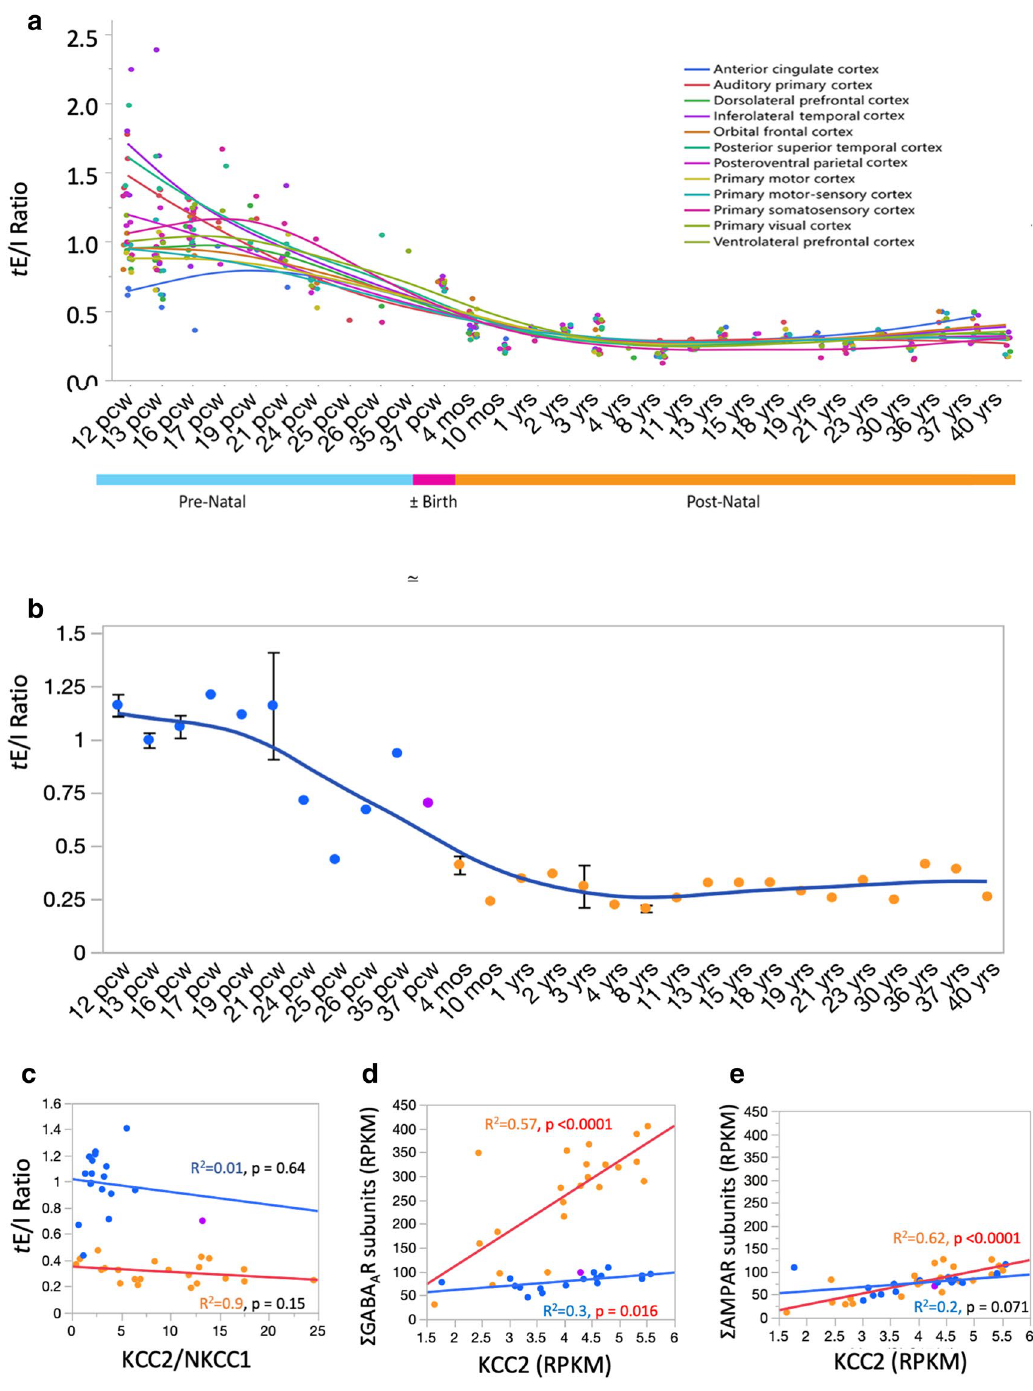
Figure 6. t E/I ratio and KCC2/NKCC1 ratio in the developing human brain. ( a ) t E/I ratios were calculated in different cortical regions against age (from 12 postconceptional weeks to 40 years, shown as categorical values in the plot) using data from the Allen Brainspan project ( n = 40 subjects). Each point represents a single cortical region per subject. Spline smooth curves, here and in ( b ), show the principal trend in values for AMPA and GABA A receptors. Please see Supplementary Data 9 for detailed number of subjects per region. ( b ) The graph shows the mean ± S.E.M. of cortical t E/I in each subject per region. The cortical t E/I in each subject is the average of all cortical regions available for each subject. ( c ) Lack of correlation between the cortical t E/I ratio in each subject and the KCC2/NKCC1ratio. KCC2 is the potassium-chloride transporter member 5 produced by the SLC12A5 gene and its expression increases during development, while NKCC1 is the Na–K–Cl cotransporter produced by SLC12A2 gene. The relationship between these transporters define the direction of chloride permeability in GABA A Rs. ( d , e ) KCC2 expression is linearly correlated with the increase of GABA A Rs ( d ) and AMPARs ( e ) after birth. Points are color coded as prenatal (blue), near birth (magenta), or post-natal (orange). Linear correlations are for data grouped as pre and postnatal